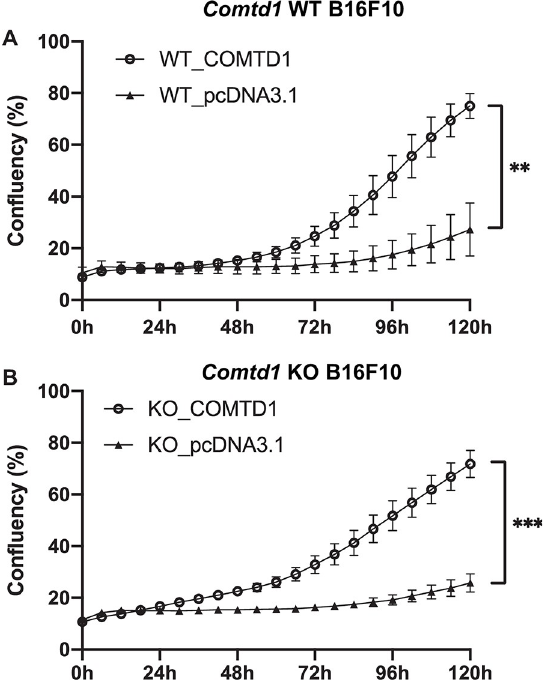
Fig 8. Proliferation curves of wild-type and Comtd1 null B16F10 cell lines after transfection. A-B, Proliferation curves of Comtd1 WT (A) and Comtd1 KO B16F10 cell lines (B) after introducing either COMTD1 expression vector (Circle) or its corresponding empty vector pcDNA3.1 (triangle). Growth was recorded by the Incucyte Zoom live-cell imaging system and data are expressed as cell confluence (%; mean ± SEM, n = 4 in KO, n = 2 in WT). ** : P < 0.01; *** : P <